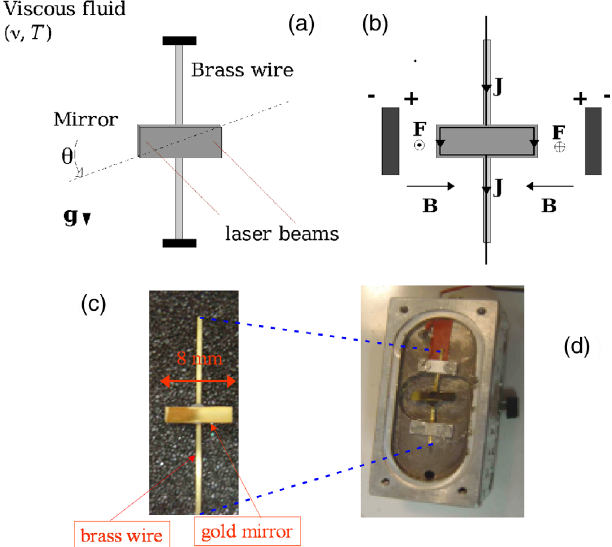
FIG. 1. (a) The torsion pendulum. (b) The magnetostatic forcing. (c) A picture of the pendulum. (d) The cell where the pendulum is